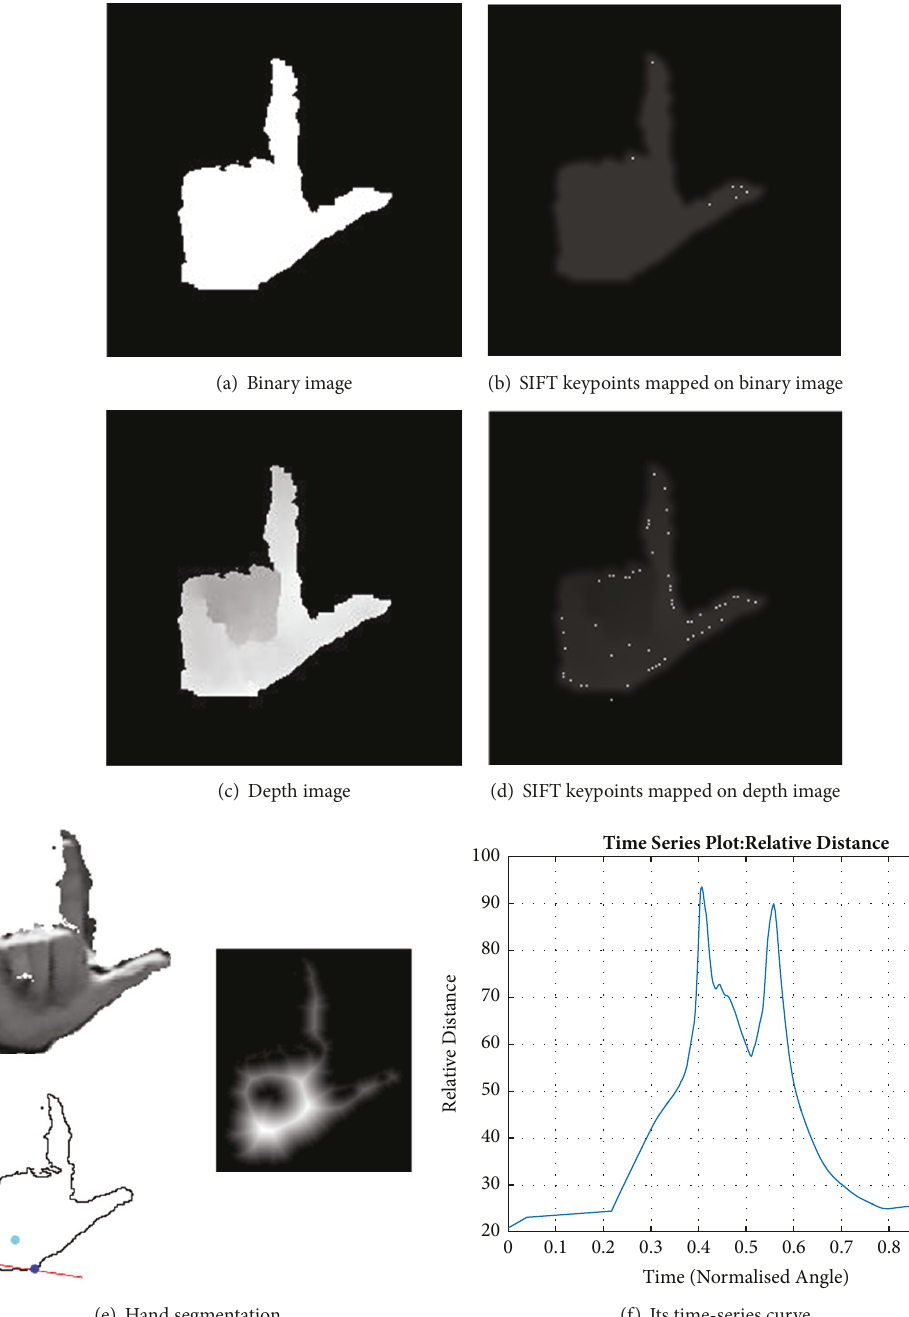
out the correspondence of SIFT keypoints between those two images. They have combined SIFT descriptor with Harris corner detector to compute SIFT features at predefined spatial scales. They enhanced the depth image contrast by applying histogram equalization without utilizing the depth values explicitly of the gesturing hand to generate contrast varying depth images. However, we have considered the depth